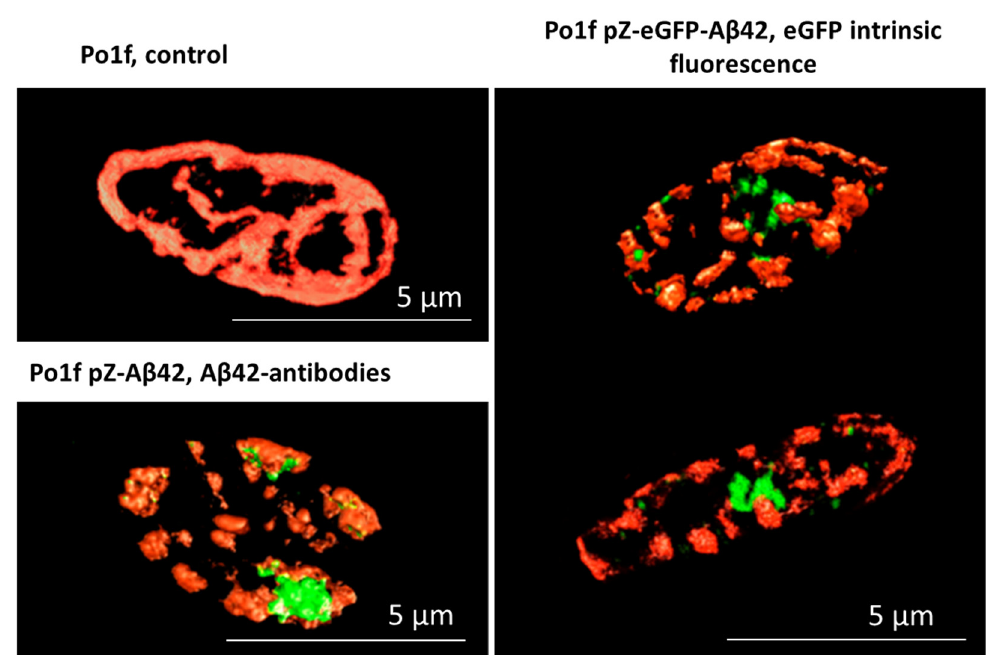
Figure 1. Structure of mitochondria in the Y. lipolytica mutants. Po1f (the control, ( top left panel )), pZ-A β 42 ( bottom left panel ), and pZ-eGFP-A β 42 ( right panel ) cells were loaded with 500 nM MitoTracker Red CmxRos (visualizing mitochondria, shown in red) for 30 min. A β 42 aggregates were visualized with eGFP intrinsic green fluorescence ( right panel ) and antibody treatment ( bottom left panel ).